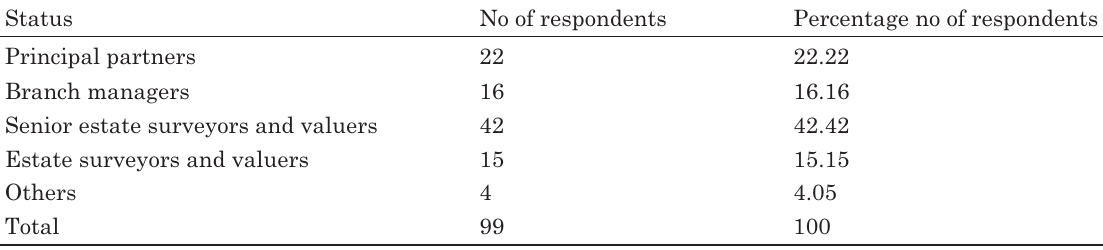
Table 2. Distribution of respondents according to status